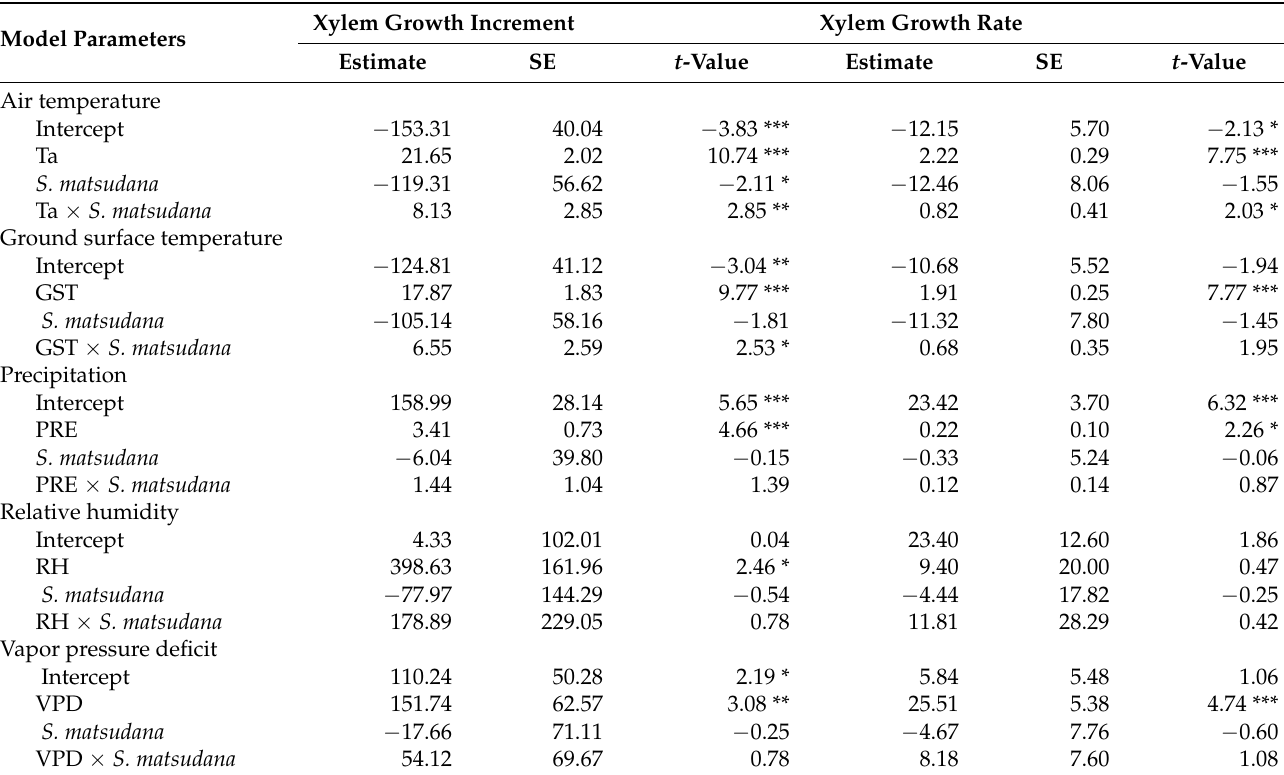
Table 3. Effects of daily climate factors on the xylem growth increment and xylem growth rate of Salix babylonica and Salix matsudana . In the models, Salix babylonica represents the reference